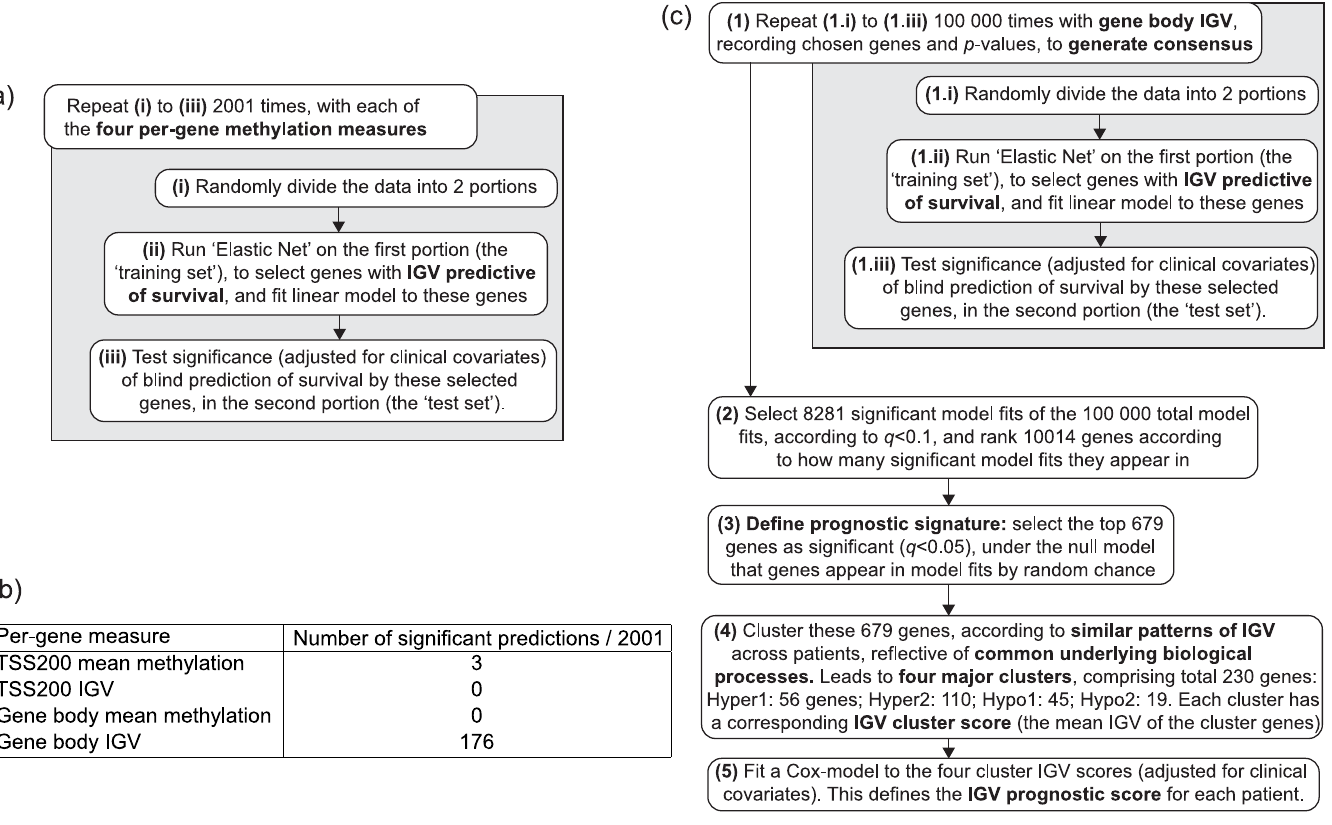
Fig 2. Overview of methods. (a) Methodology overview for comparison of the four per-gene methylation measures. (b) Results of this comparison. (c) Methodology overview for calculation of ovarian cancer IGV prognostic